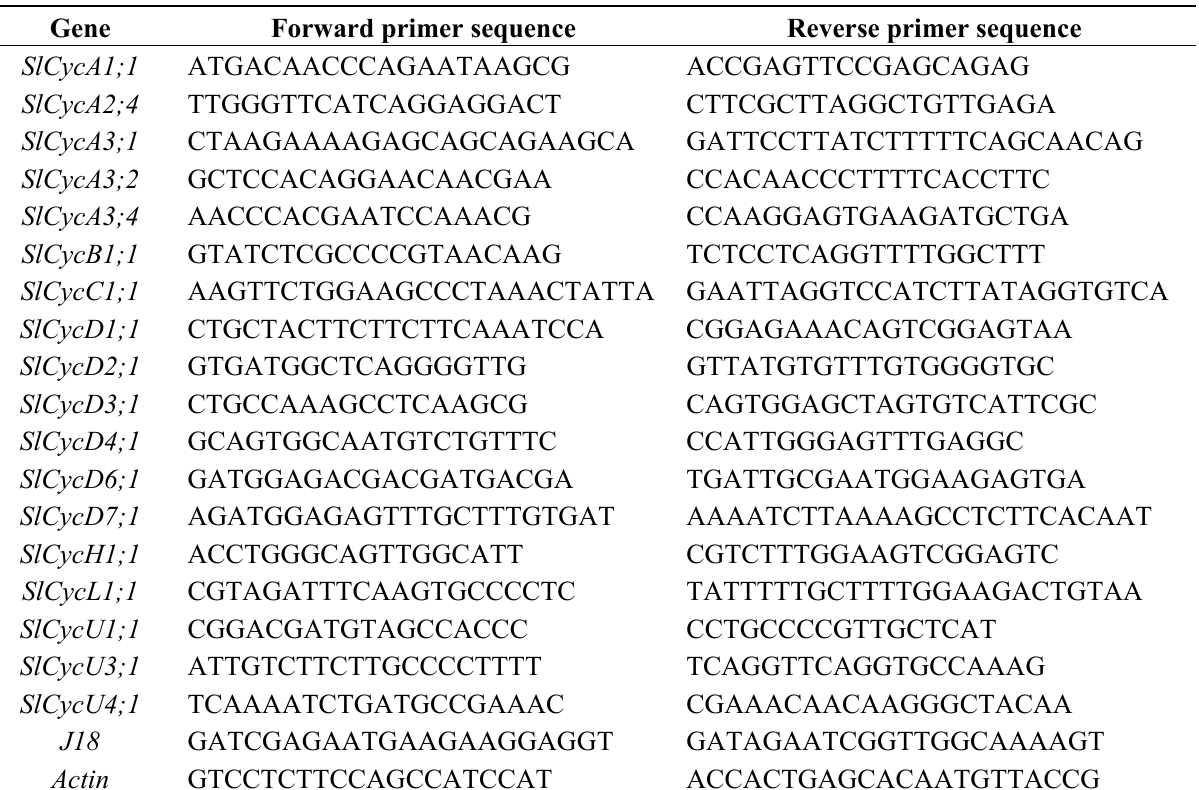
Table 3. List of primers used for Real-time